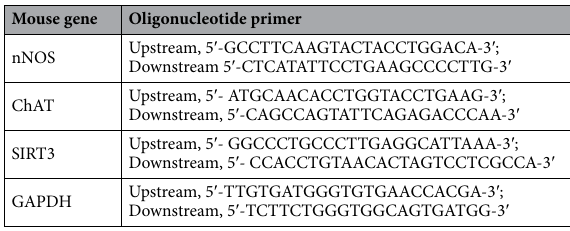
Table 1. List of oligonucleotide primers used in this study.